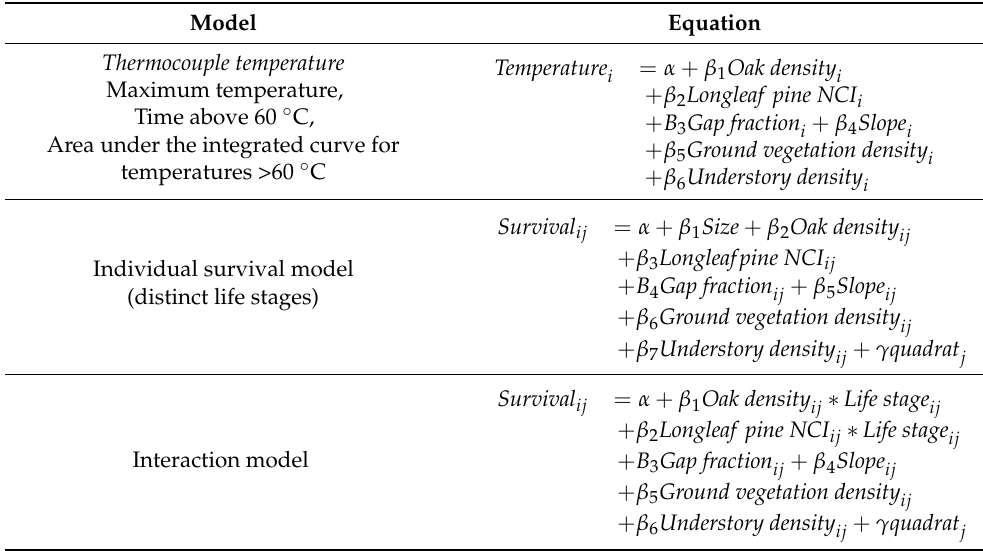
Figure A3. Survival probability as a function of longleaf pine NCI, with values partitioned by life stage. Results shown from full GLMM containing interactions between life stage and neighborhood metrics as well covariates for gap fraction, slope, understory density, and ground vegetation density. Shaded ribbons indicate 95% confidence intervals of parameter estimates by life stage. Table A2. LM and GLMM model equations used to analyze fire temperature response and individual longleaf pine survival probabilities, for thermocouple i and individual i, respectively. The γ s are normally distributed random intercept terms for j